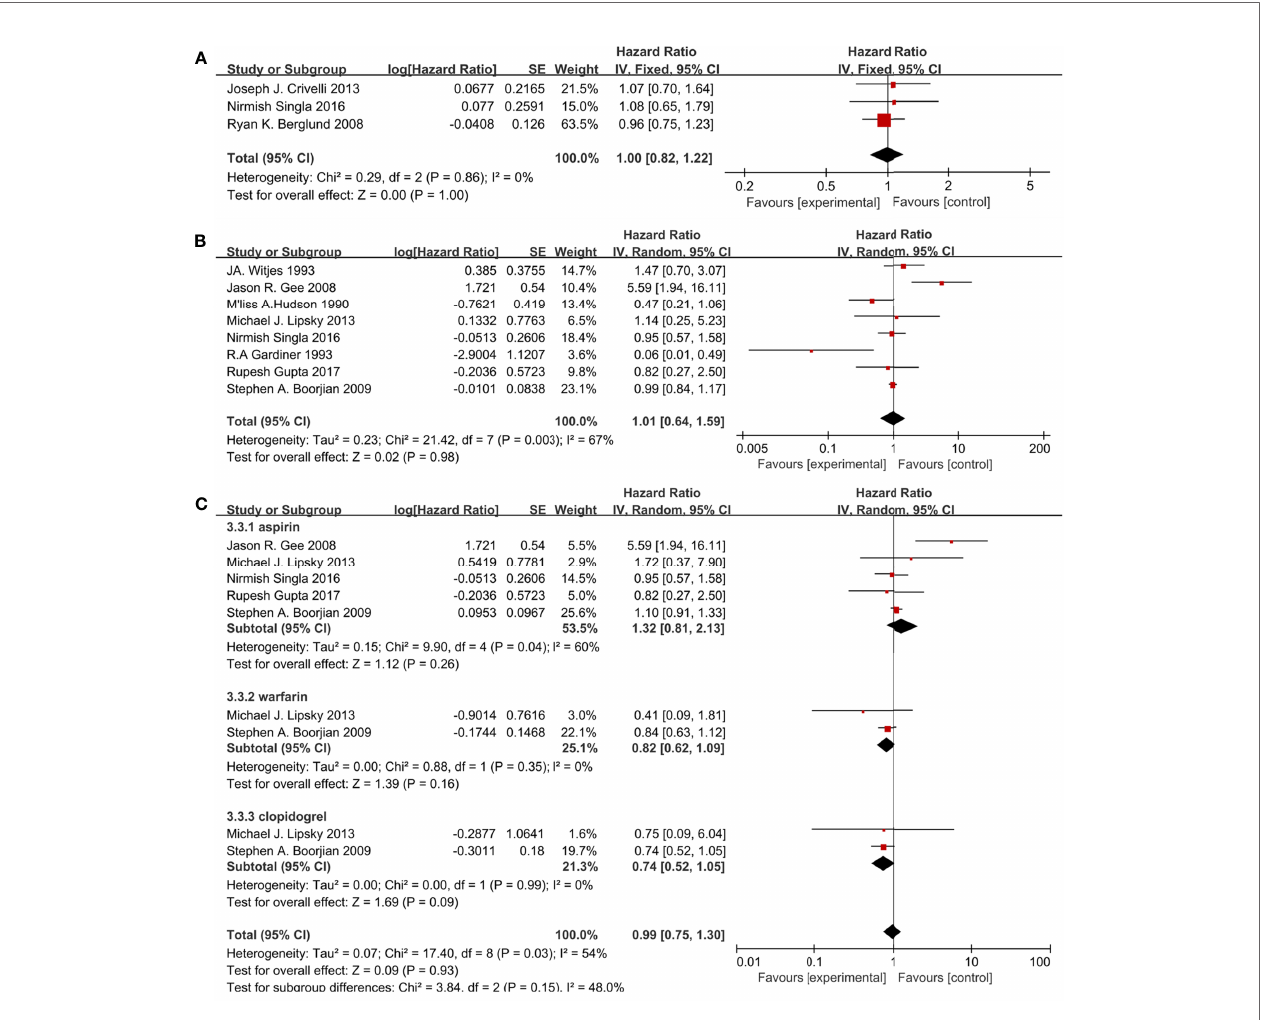
FIGURE 4 | Forest plot for cardiovascular drugs ’ effect on RFS: (A) Statins, (B) fi brin clot inhibitors, (C) subgroup analysis of fi brin clot inhibitors (aspirin, warfarin, and